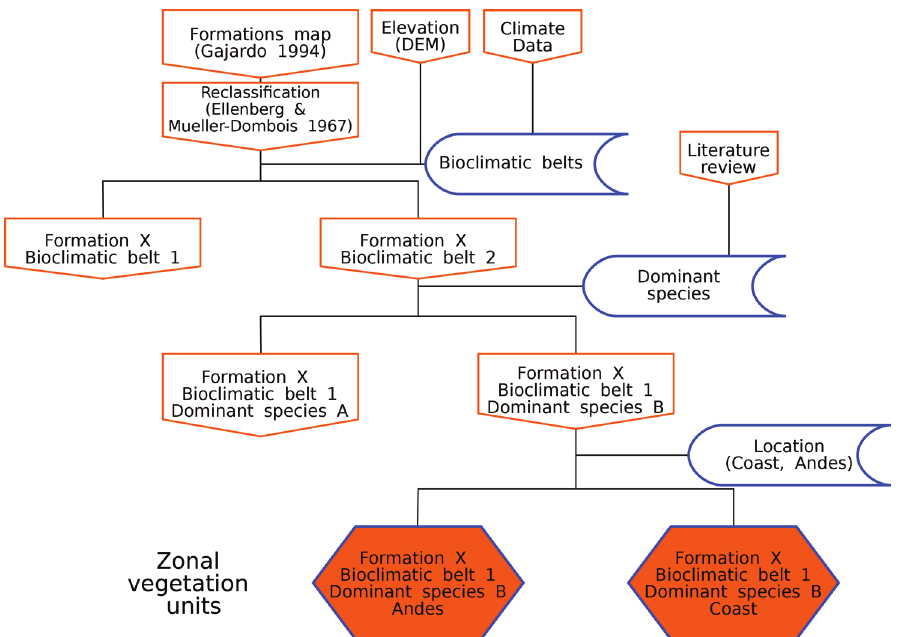
Figure A1. Flowchart depicting the methodology employed for the identification of zonal vegetation units by Lue- bert and Pliscoff (2006a,